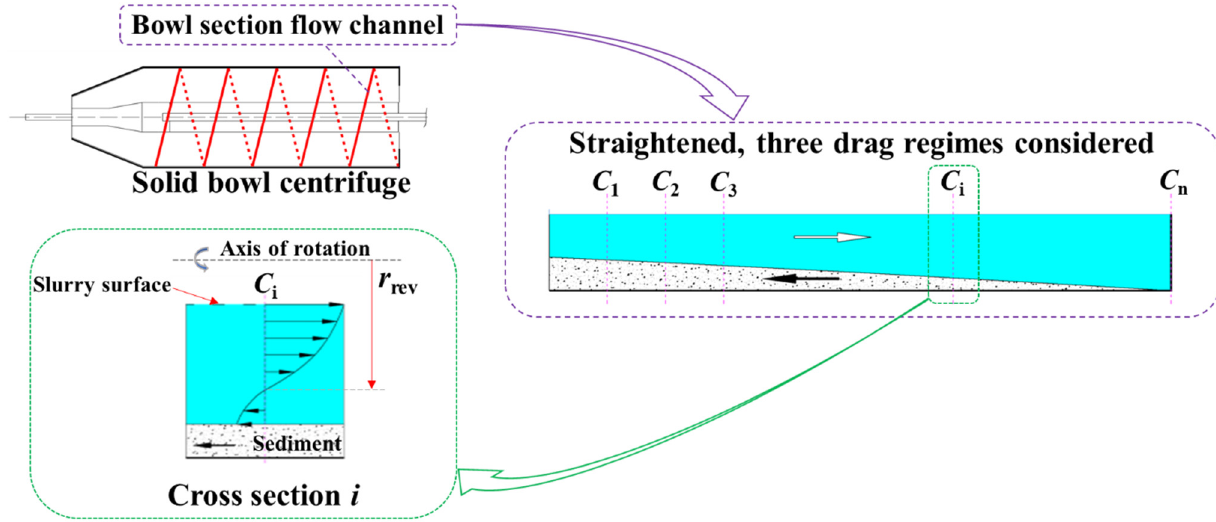
Figure 1. A schematic of the SBC model (Bai et al., [14]). r rev is the radius where the flow direction is reversed at the interface between the reversed flow (backflow) and the positive flow (in direction to the weir), relative to the axis of rotation.